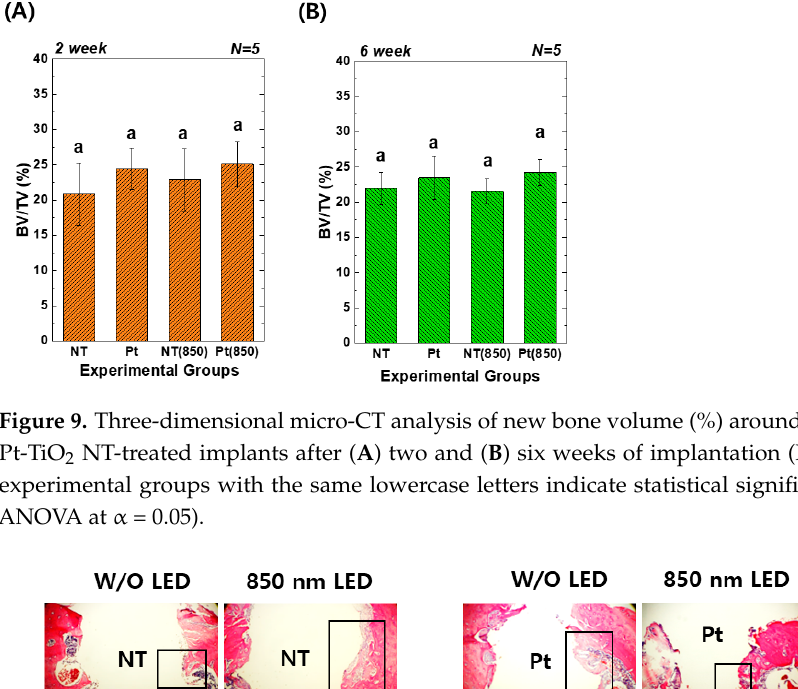
isting bone (blue arrows in Figure 11).